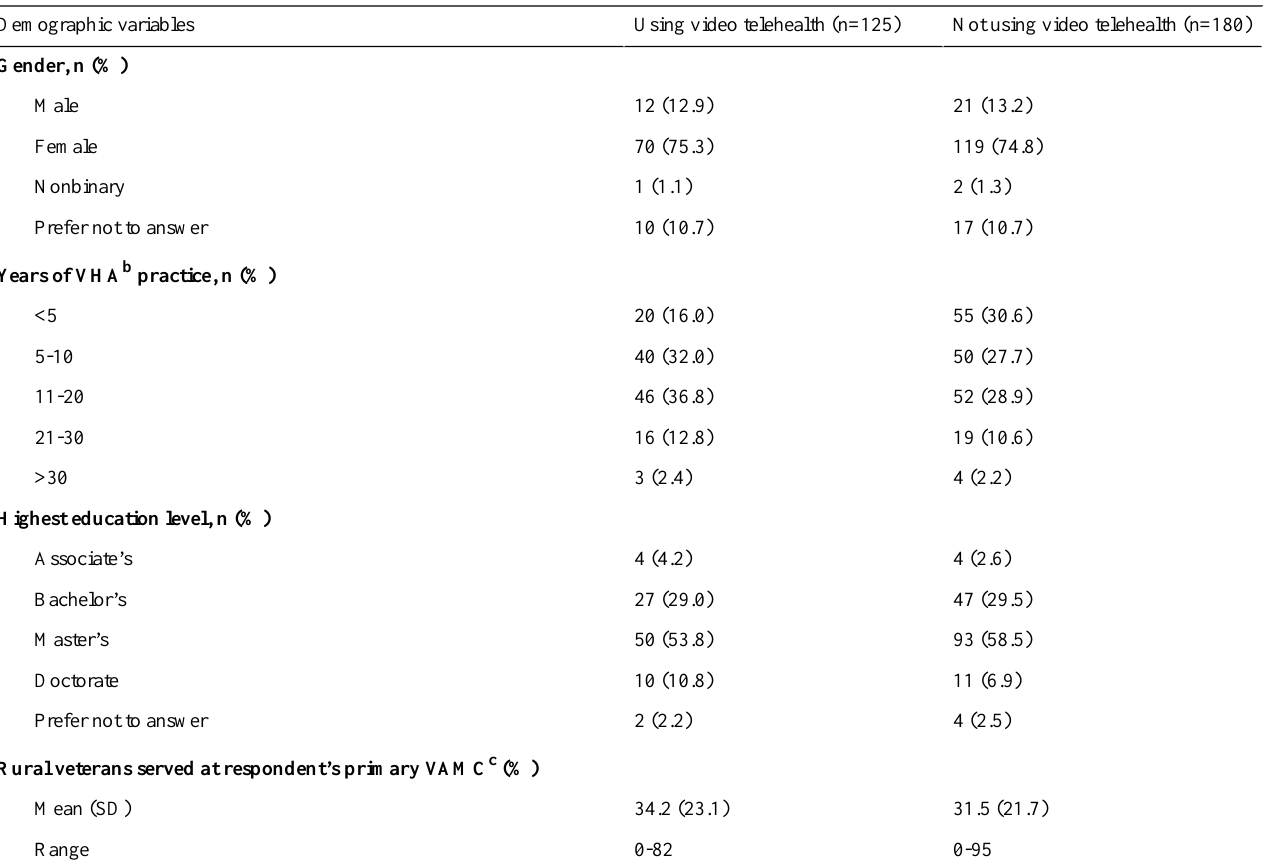
Table 1. Respondents’characteristics by use of video telehealth with older veterans. a